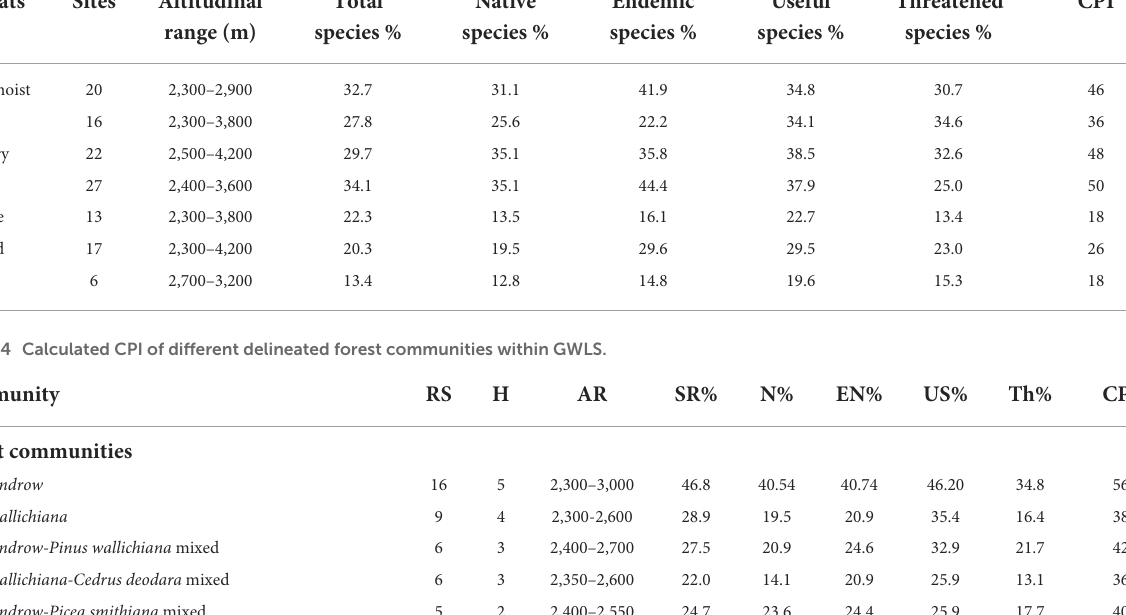
Total Native Endemic Useful range (m) species % species % species % species % species %